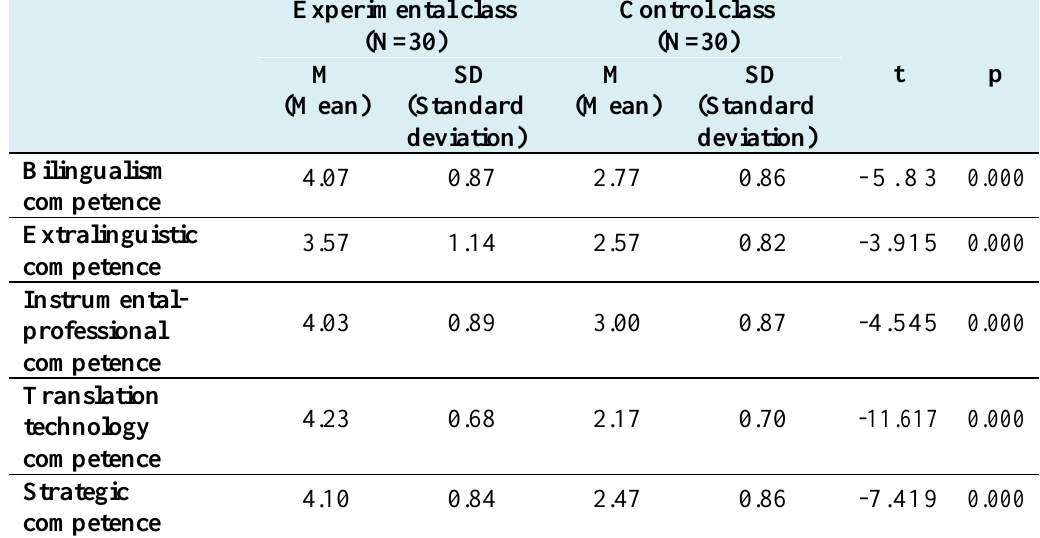
Translation sub-competence scale of the experimental class and the control class after the teaching experiment